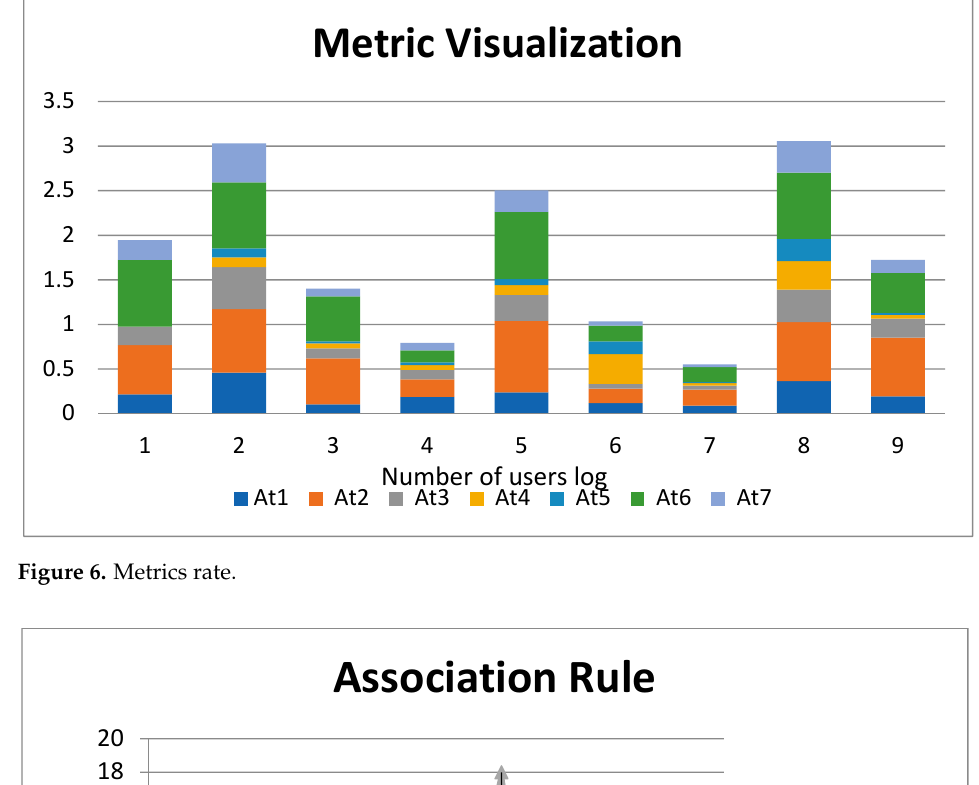
Figure 6. Metrics rate.